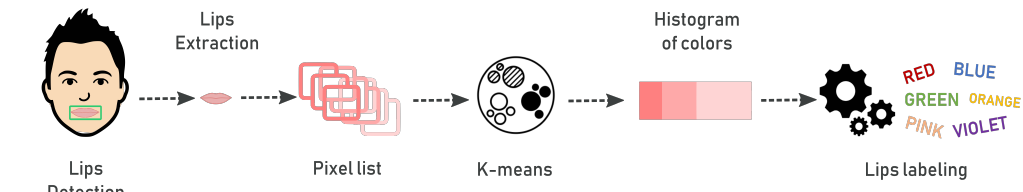
Figure 5. Pipeline to detect the color of lips.